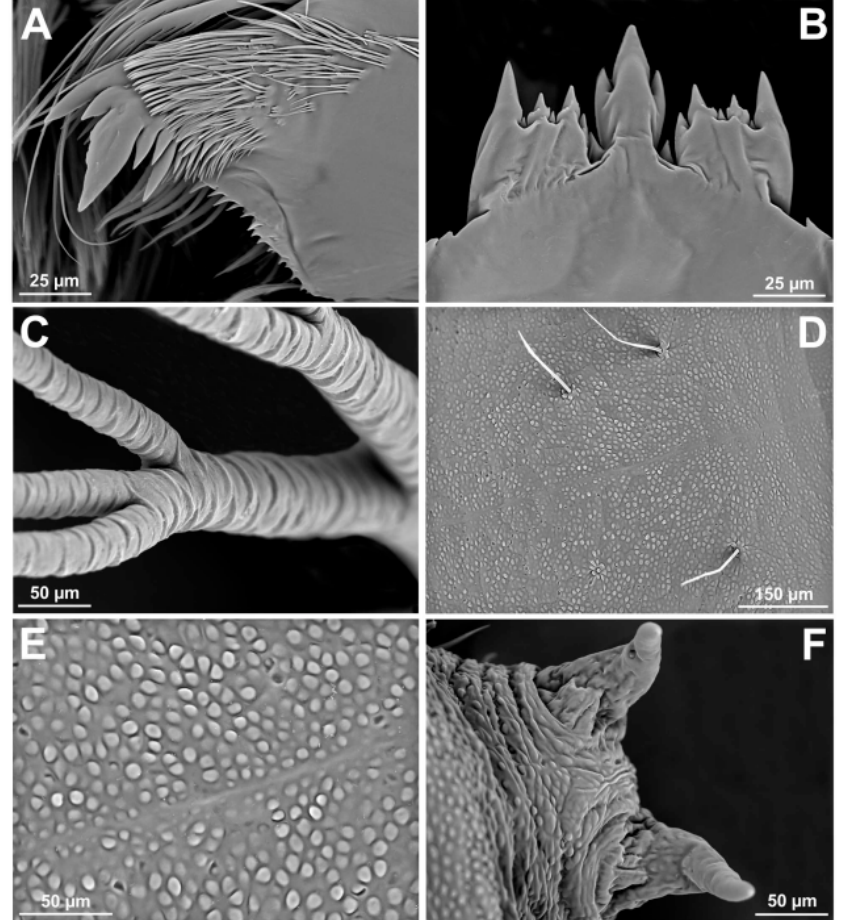
Figure 6. Scanning electron micrographs of Prosimulium supernum n. sp. ( A ) Larval mandible, apex, aboral surface. ( B ) Hypostoma, ventral view (teeth tilted dorsally). ( C ) Pupal gill filaments, showing surface sculpture. ( D ) Pupal thoracic sculpture and trichomes, dorsal view; the ecdysial line is